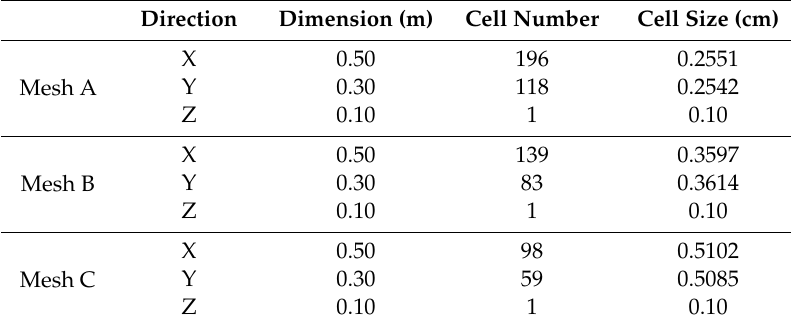
Table 3. Characteristics of Mesh A, B, and C.